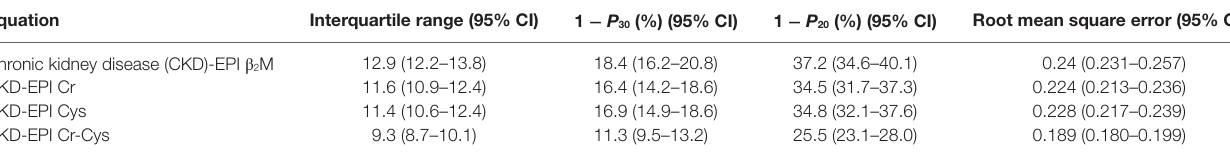
TABLe 2 | Performance of beta-2 microglobulin ( β 2 M), creatinine (Cr), and/or cystatin C-derived equations .